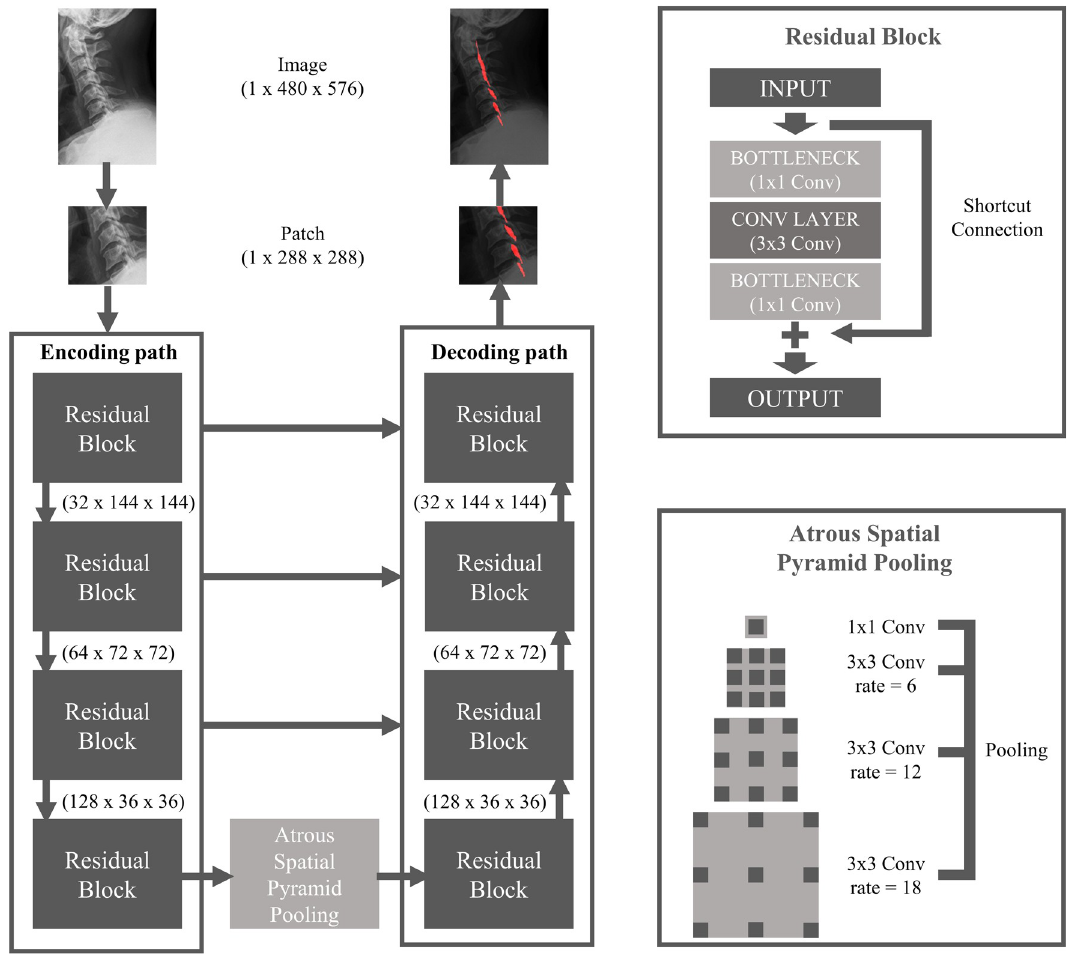
Fig 2. The architecture of the deep convolutional neural network used for OPLL segmentation. OPLL, ossification of the posterior longitudinal ligament.